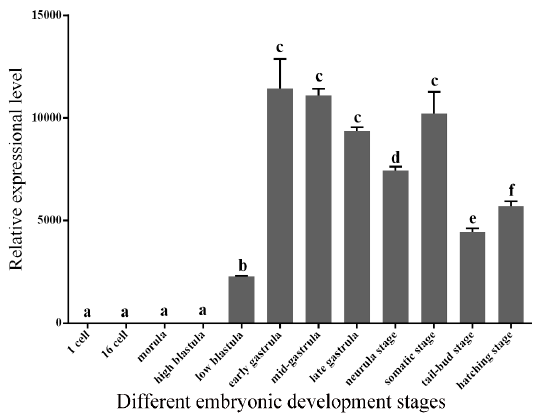
Figure 6. Relative expression of GATA6 during embryonic development from fertilized egg to the hatching stage in P. olivaceus . qRT-PCR analysis was used to quantify GATA6 mRNA with 18sRNA as a reference. The relative expression variance is presented as a ratio (amount of GATA6 mRNA normalized to the values of the corresponding reference genes). The data are shown as the mean ± SD ( n = 3). Columns with different letters show a significant difference ( p < 0.05).